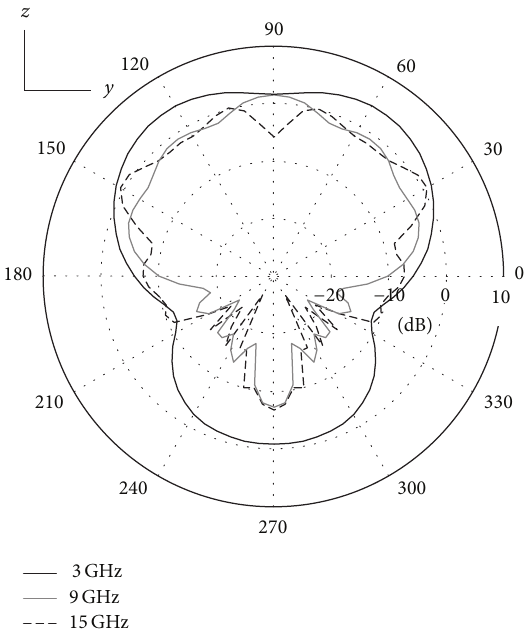
Figure 14: Radiation pattern of a conical antenna with elliptical aperture and reflector in the yz plane.